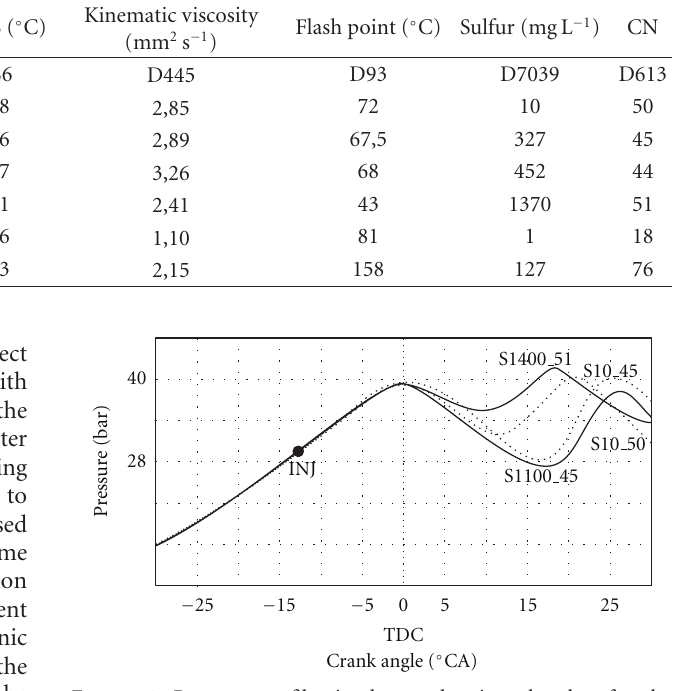
Figure 1: Pressure profiles in the combustion chamber for the base fuels with the highest CNs (S10 50 and S1400 51) and their respective formulations (S10 45 and S1100 45) with the lowest CN.